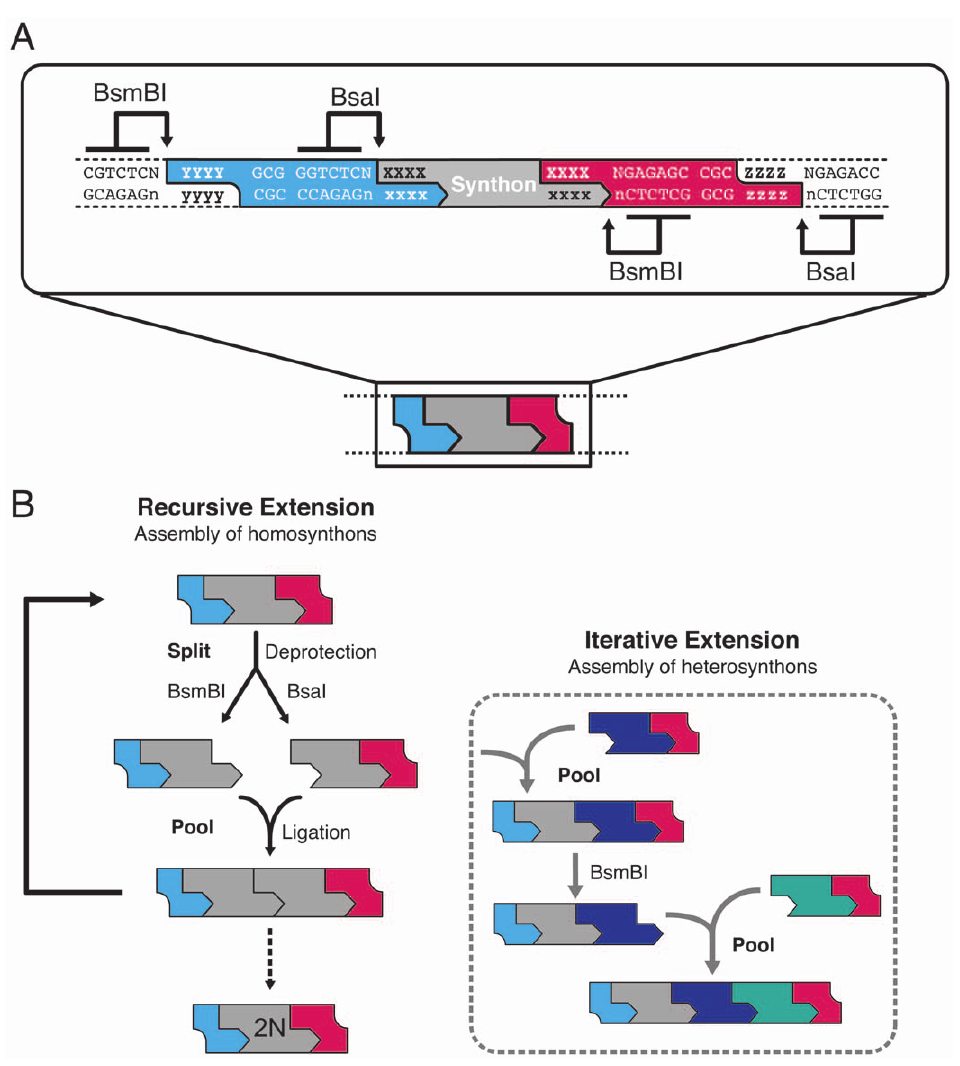
Figure 1. Split-and-pool assembly of DNA synthons. (A) Entry synthons are flanked on both sides by recognition sequences for the type IIS endonucleases BsaI and BsmBI. Restriction by either BsaI or BsmBI selectively exposes user-definable 4-base cohesive overhang sequences (5 9 -XXXX vs. 5 9 -xxxx) at one end of the synthon, while maintaining orthogonal protection groups (with 5 9 -YYYY vs. 5 9 -zzzz overhangs) at the opposite end. (B) Schematic representation of the ‘split-and-pool’ assembly principle. Cohesive ends of entry synthons are selectively deprotected by digestion with either BsaI or BsmBI. Pooling of the deprotected synthons in the presence of ligase results in unidirectional assembly, affording an idempotent tandem repeat synthon by restoration of orthogonal protecting groups on opposite ends. Each product module can recursively enter the assembly cycle (left panel) N times to yield concatameric synthons with 2N elements. The same strategy can be applied to the assembly of heterosynthons (dashed box), which allows for the engineering of chimeric and multimodular proteins or polycistronic genes.